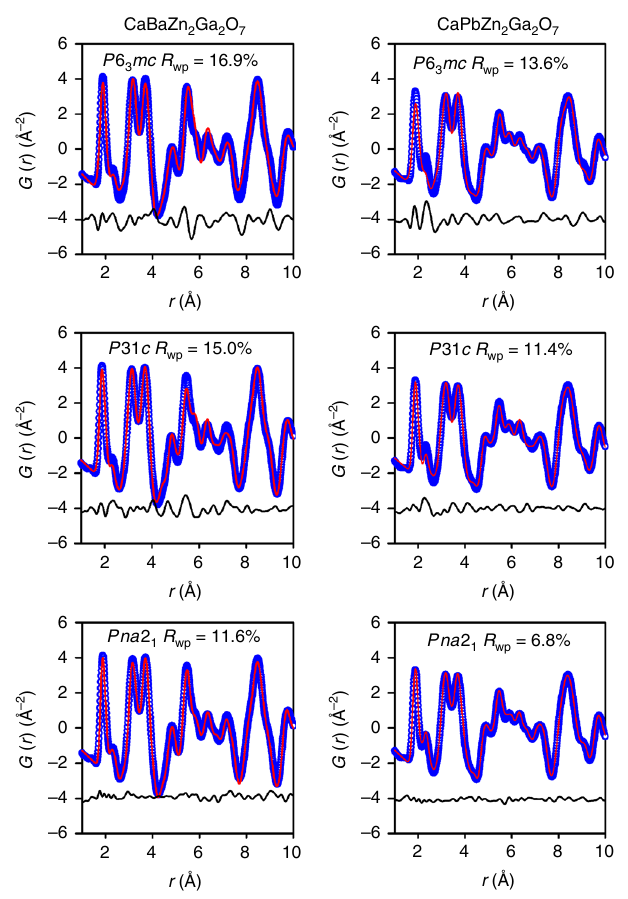
Fig. 3 Real space structure re fi nements. Real space Rietveld re fi nements of neutron PDF data for CaBaZn 2 Ga 2 O 7 and CaPbZn 2 Ga 2 O 7 with P 6 3 mc , P 31 c, and Pna 2 1 models. Source data are provided as a Source Data